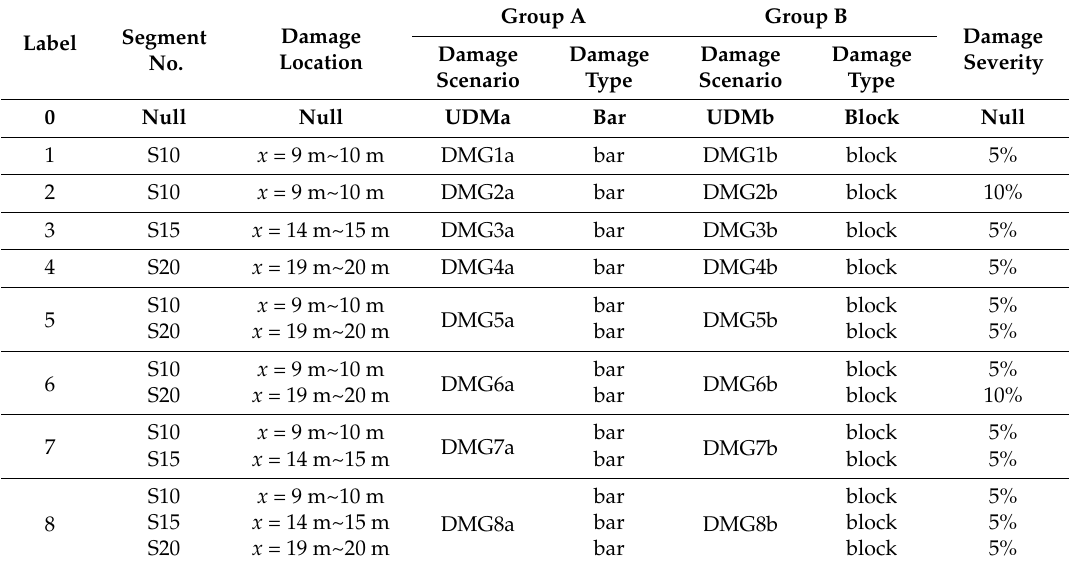
Figure 6. Block damage scenarios: ( a ) 5% damage; and, ( b ) 10% damage. Table 2. Damage cases of Groups A and B considered in experimental verification.